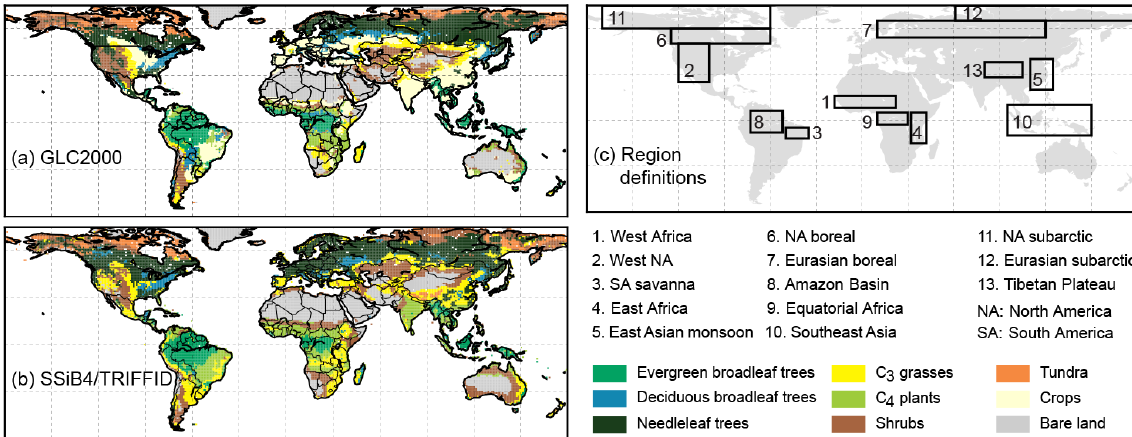
Figure 3. Dominant vegetation type comparison between (a) GLC2000 and (b) SSiB4/TRIFFID, and (c) region definitions.